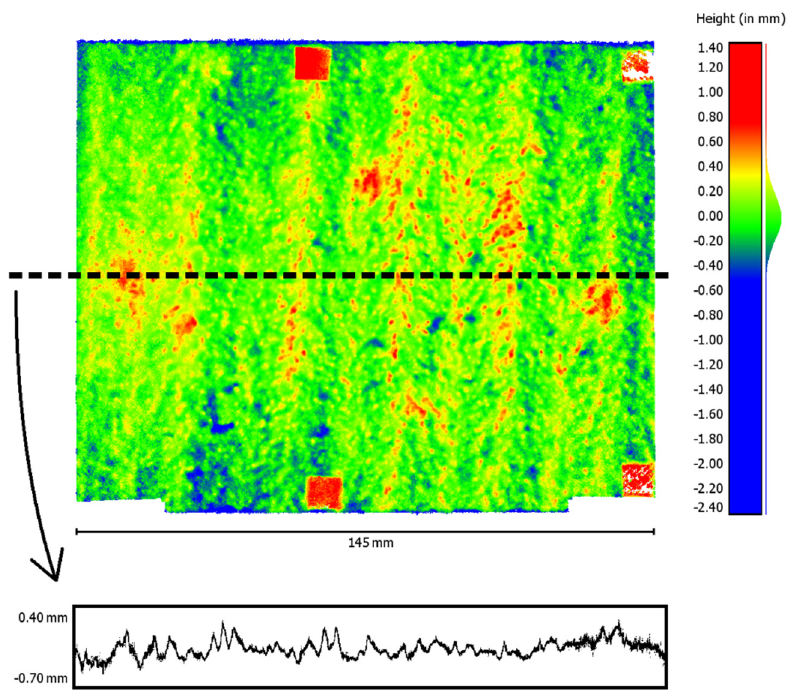
Figure 14. Point cloud (top, left), extracted profile line (bottom, 10-fold scaled in height), and histogram of the height values (right) after reconstruction with the new parameter set.